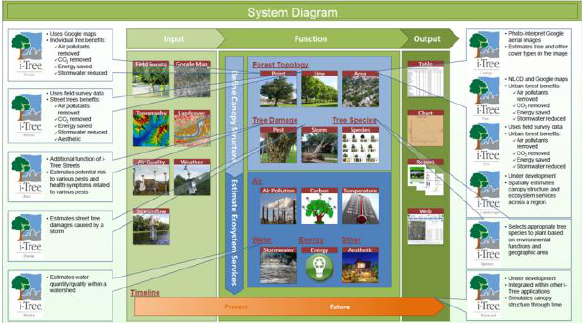
Figure 2. i-Tree desktop and web-based applications and system diagram by Hirabayashi et al. (2011).